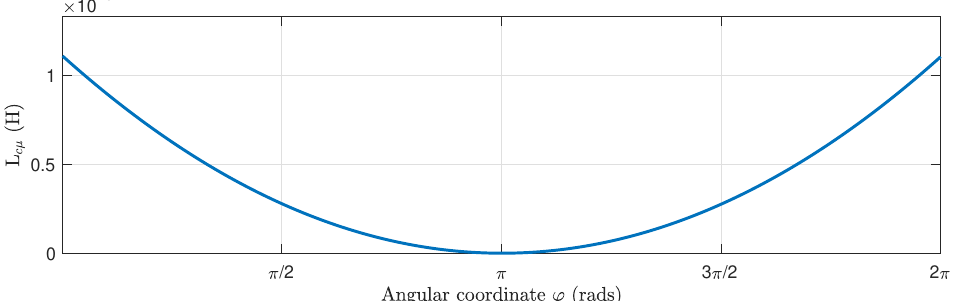
Figure 14. Mutual inductance between an elementary conductor placed at the origin and an ele- mentary conductor placed at a given angular coordinate ϕ for the IM given in Appendix A, without eccentricity. This corresponds to the first column of matrix L c µ ( 13 )